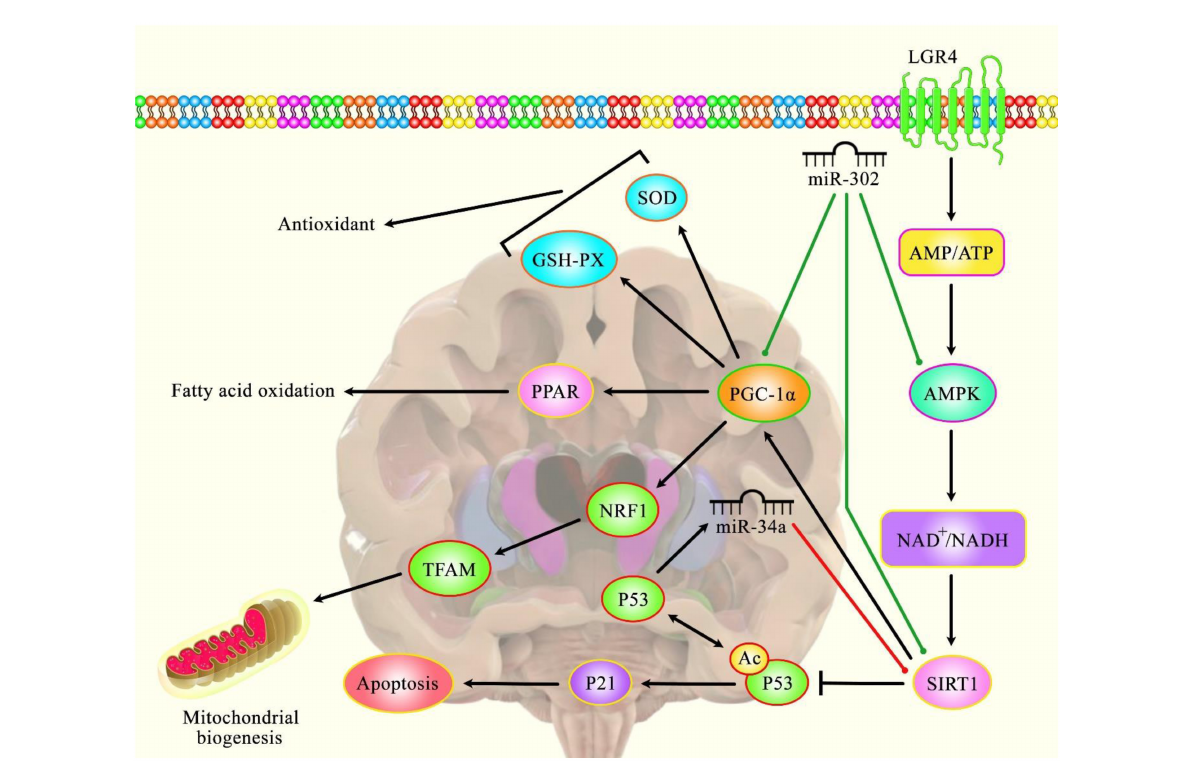
FIGURE1 A schematic diagram of the role of several miRNAs in the modulation of Huntington’s disease.